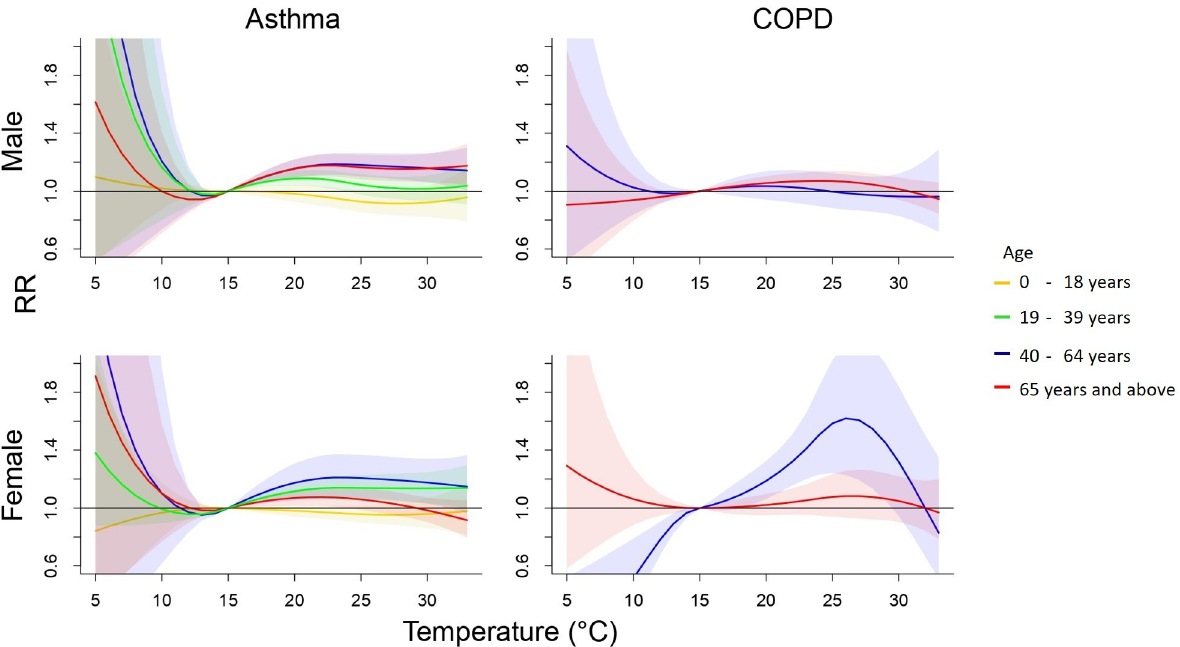
Fig 3. Cumulative 4-day (lag 0–3) relative risk (95% confidence interval) of sex-age specific ERVs for asthma and COPD associated with daily average